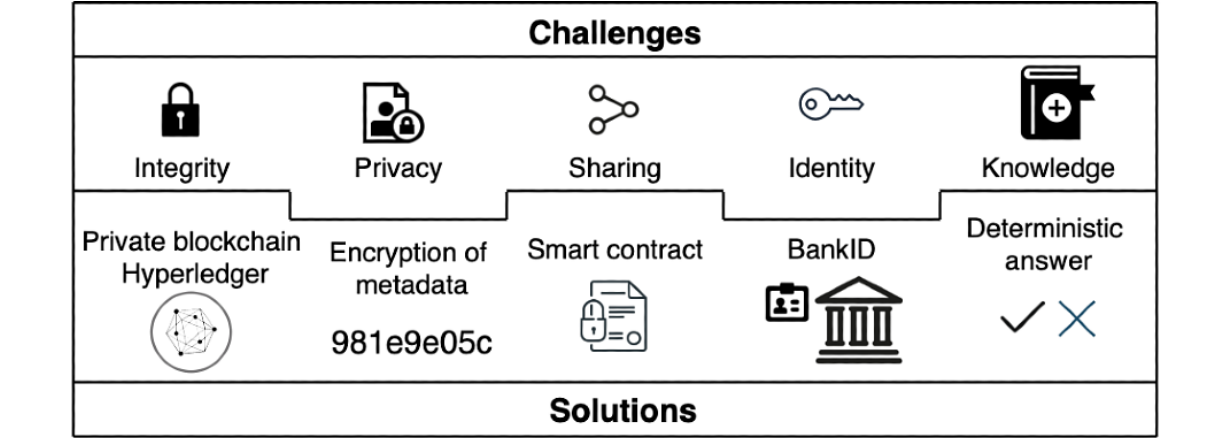
Figure 3. Architectural decisions in addressing the 5 key